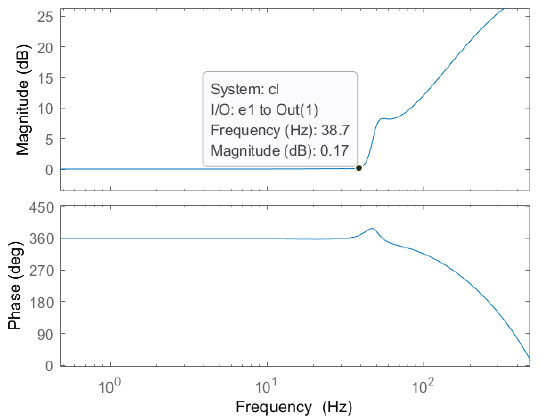
Figure 12. Bode diagram of closed-loop system.